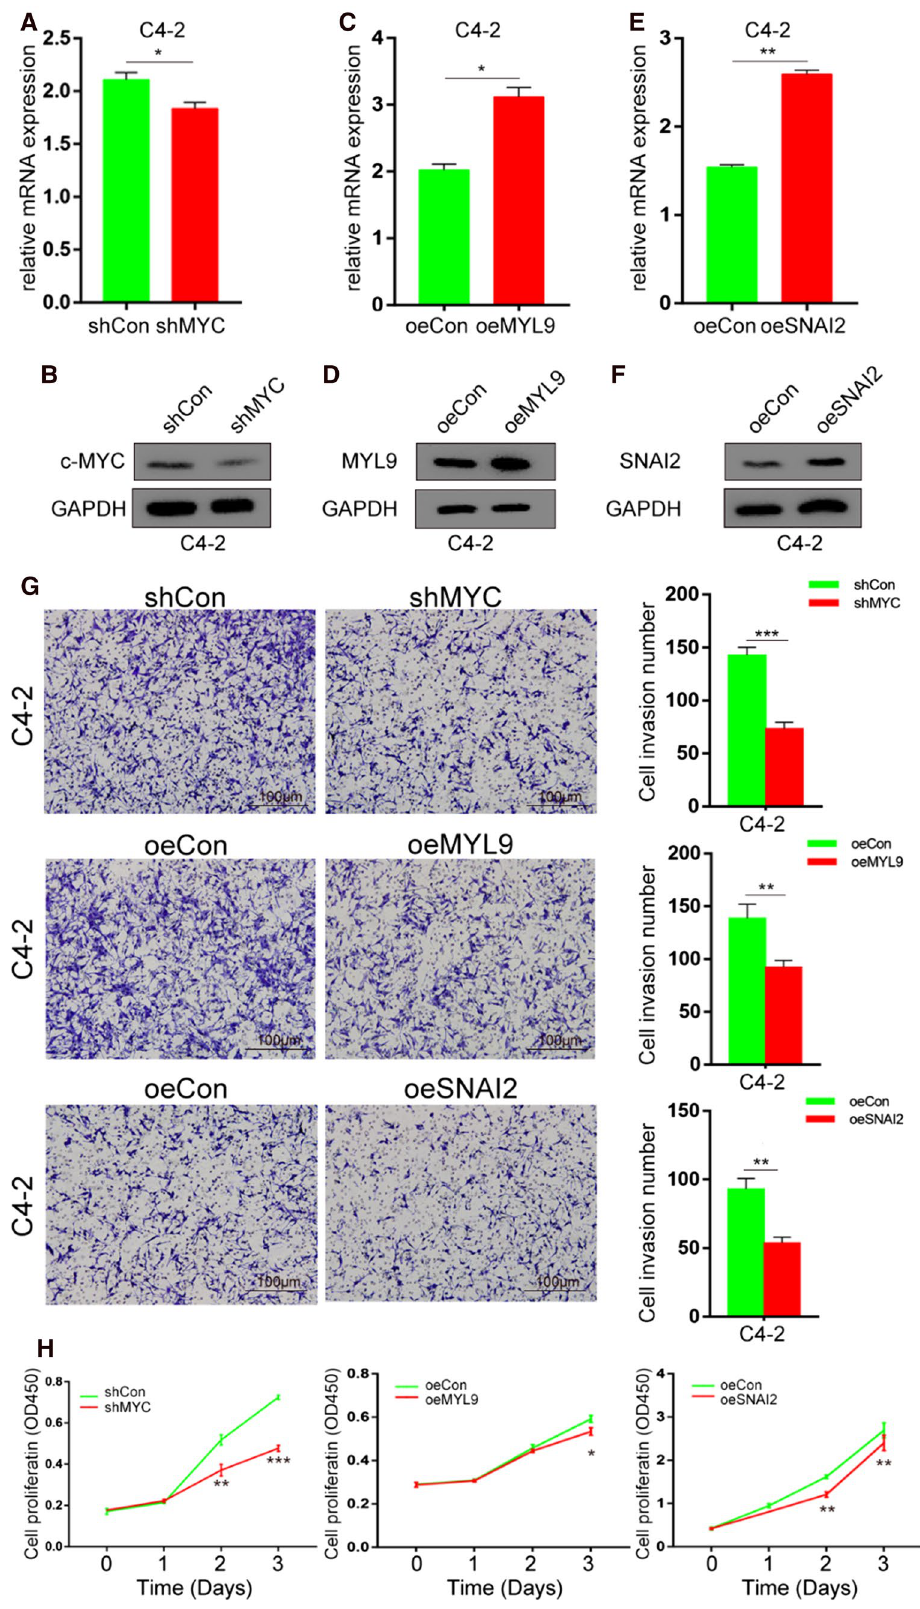
Fig. 10 MYC, MYL9 and SNAI2 influence C4-2 cell invasion and proliferation. A , B The mRNA and protein expression of MYC after MYC knock-down (shMYC) plasmids transfected into C4-2 PCa cells. C , D The MYL9 mRNA and protein level after overexpression MYL9 (oeMYL9) plasmids trans- fected into C4-2 cells. E , F The expression of SNAI2 in both mRNA and protein level after C4-2 cells transfected by over- expression SNAI2 (oeSNAI2) plasmids. G The invasion abil- ity of C4-2 cells after transfec- tion with different plasmids. H The proliferative ability of C4-2 cells after transfection with different plasmids. The expression level of mRNA and protein was used GAPDH as inner control. * represents P < 0.05, ** represent P < 0.01, *** represent P <